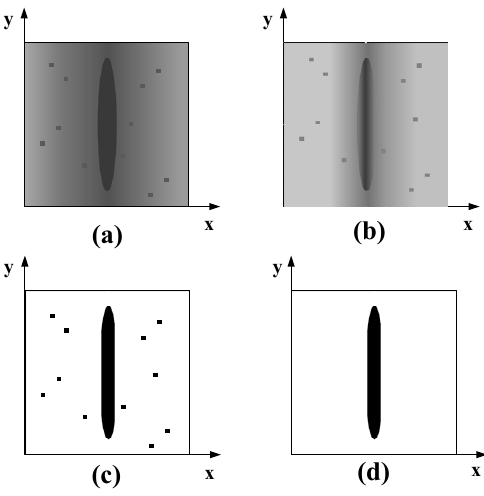
Figure 6. The image processing results of threshold segmentation. ( a ) Gray mini-crack feature image; ( b ) Image enhancement; ( c ) Threshold segmentation; ( d ) Morphological denoising.